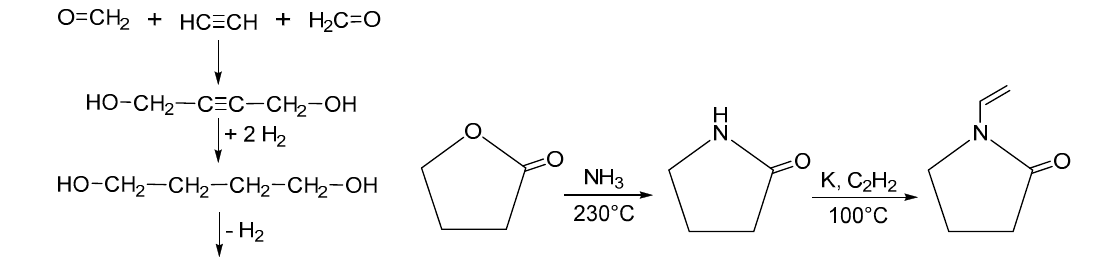
Figure 4. Synthesis of N-vinylpirrolidone.